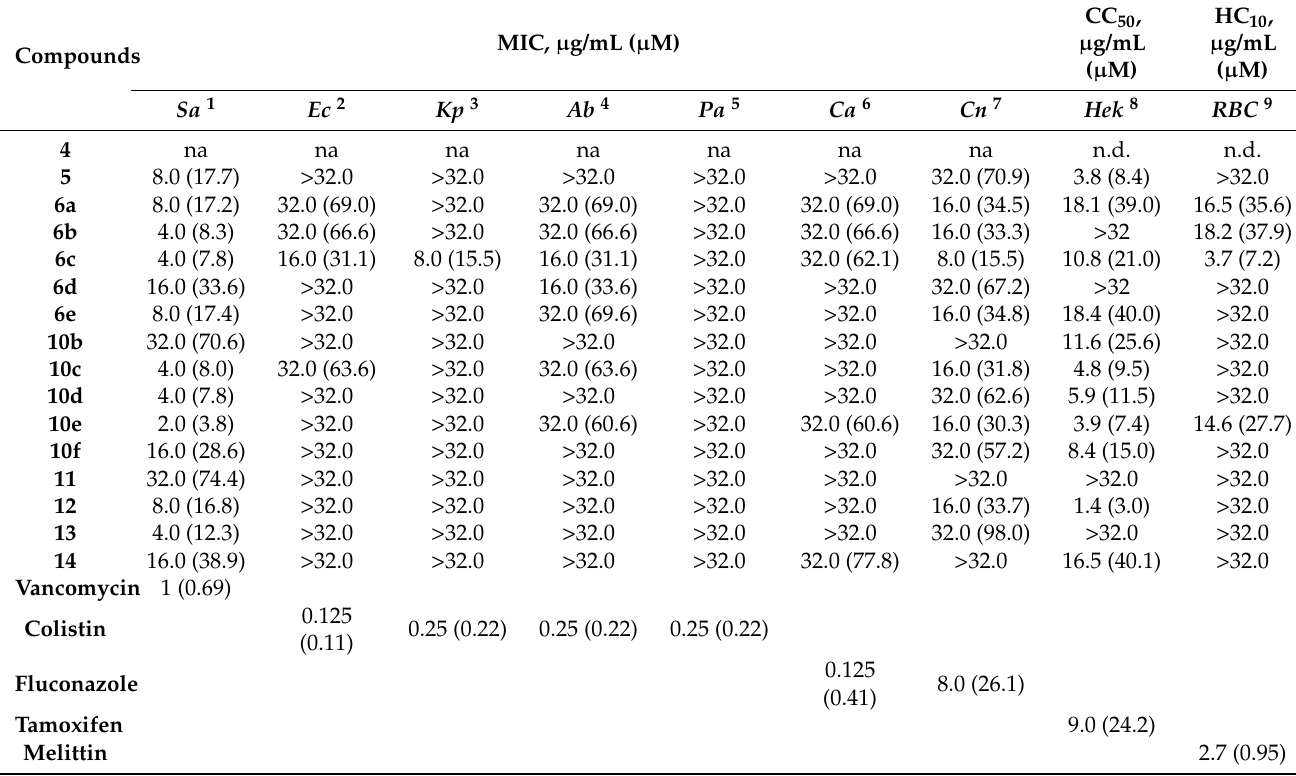
Table 1. Antimicrobial activity (MIC), cytotoxicity (CC 50 ), and hemolytic activity (HC 10 ) of the new 3-aryl- 5H -pyrrolo[1,2- a ]imidazole and 5 H -imidazo[1,2- a ]azepine quaternary salts.